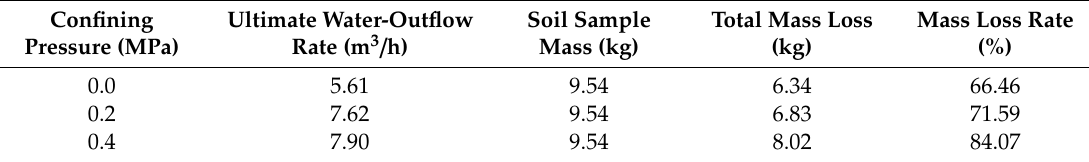
Figure 14. Variation tendency of monitoring objects’ characteristic value with confining pressure ( P c ). (a) Occurrence time of Transition Point I, II along with confining pressure; (b) Ultimate water-outflow rate along with confining pressure; (c) Mass loss rate along with confining pressure.